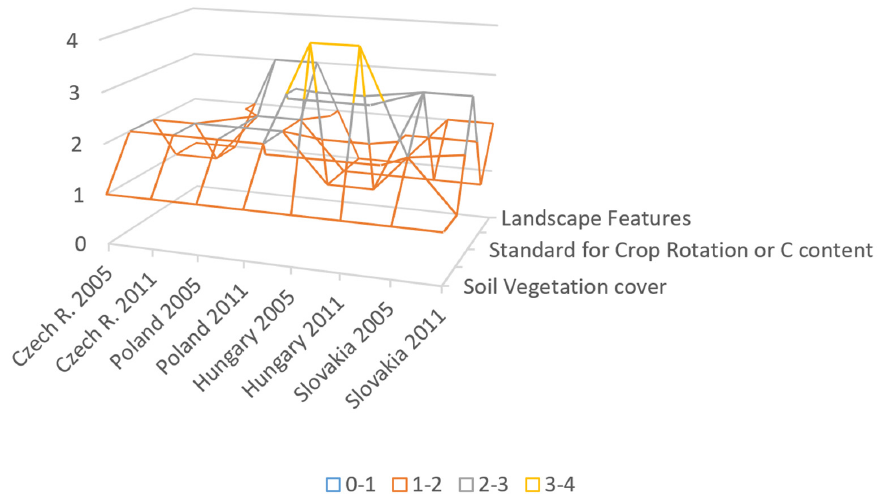
Figure 1. Identification of Soil-Water Effects. Note: 1, most directly; 5, least directly.